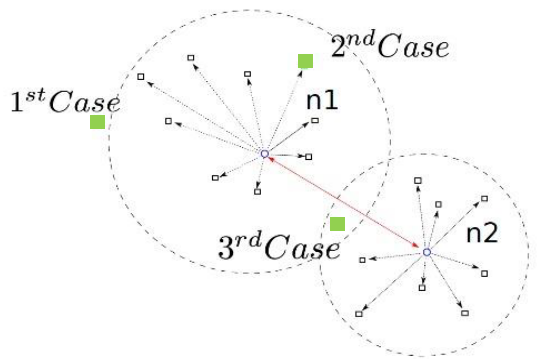
Figure 10 . Green square points correspond to the three possible cases representing the creation of a new neuron or the assignment to an existing one of the input point. The black square points are the samples assigned to a neuron node (the blue